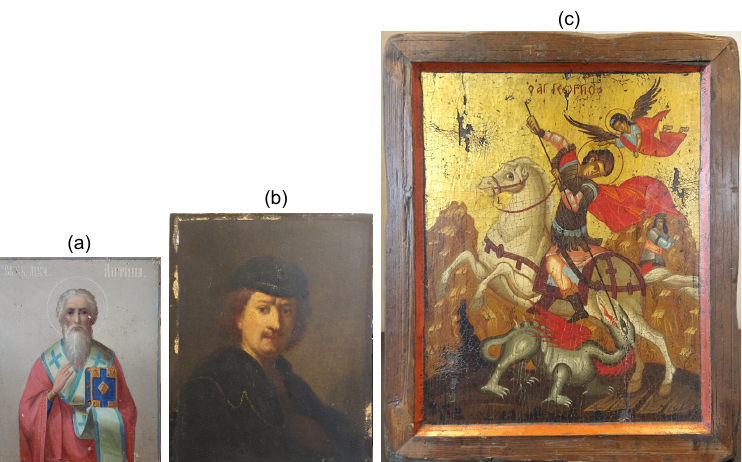
Figure 1. ( a ) RGB image of the 19th century Russian icon showing St. Nicholas (14 cm × 18 cm). The paint’s surface shows various small surface defects and there is a preparatory sketch in pencil beneath the painted surface. ( b ) RGB image of a reduced-size copy of an auto-portrait by Rembrandt (18 cm × 21 cm), with the frame removed. ( c ) RGB image of the St. George painting (35 cm × 42 cm). The surface shows several large paint lacunae, exposing the canvas substrate that was glued onto the